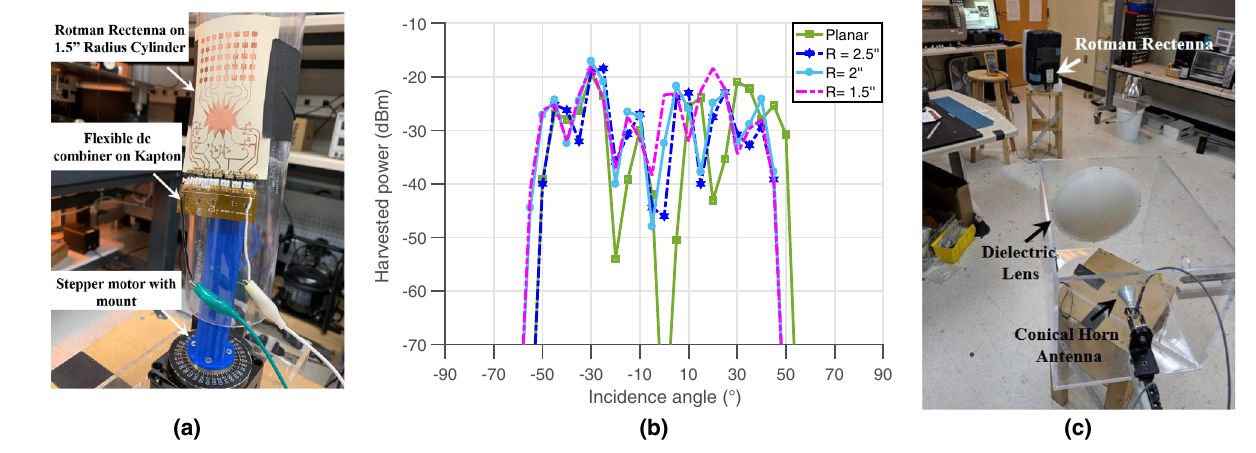
Figure 7. ( a ) Picture of the flexible Rotman lens-based rectenna placed on a 1.5 ″ radius cylinder and ( b ) measured harvested powers versus incidence angles for different curvatures, ( c ) long-range harvesting testing